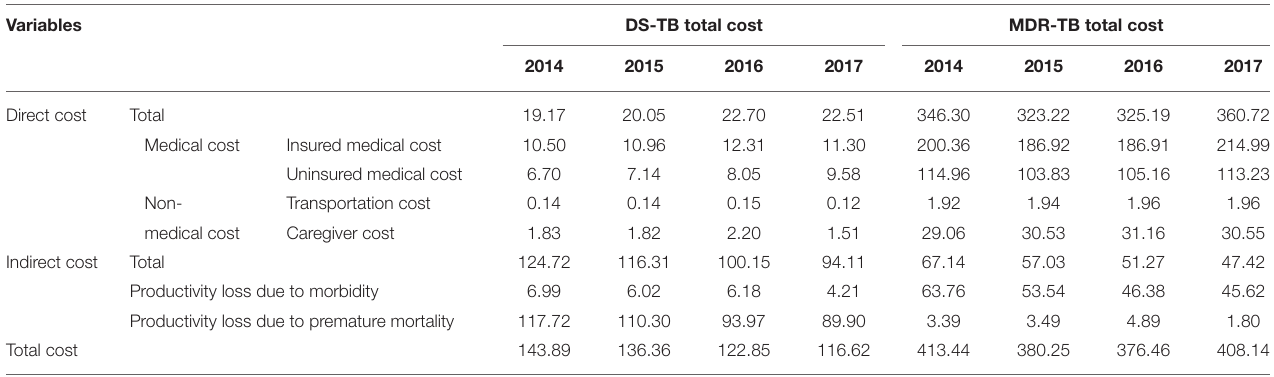
TABLE 4 | Total cost of drug-susceptible tuberculosis (DS-TB) and multidrug-resistant tuberculosis (MDR-TB) by gender and age, 2014–2017 (Discount rate: 3%, Unit: $1 million). Variables